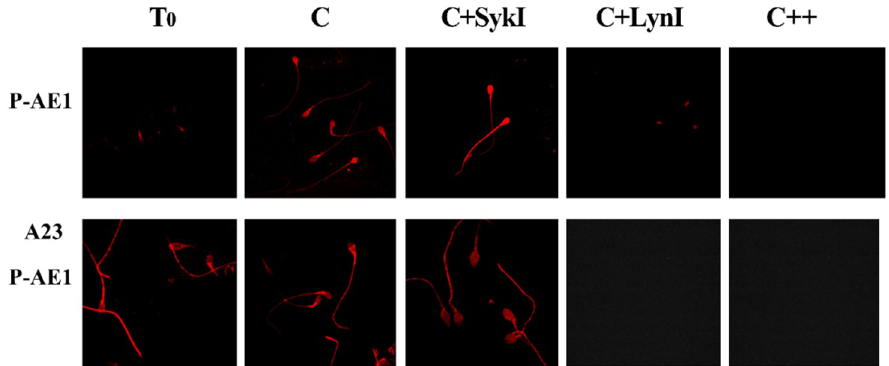
Figure 5. Selective phosphorylation of spAE1 on Tyr359 residue. Sperm cells, isolated and treated for 120 min under capacitating conditions in the absence (C) or presence of protein kinase Syk (SykI) or Lyn (LynI) inhibitors, were analyzed at the end of incubation (P-AE1) or after further incubation for 30 min with A23187 (A23 P-AE1) for the AR. Immunofluorescence with anti-P-AE1 antibody was performed as described in Methods. Panels are representative of 6 separate experiments.